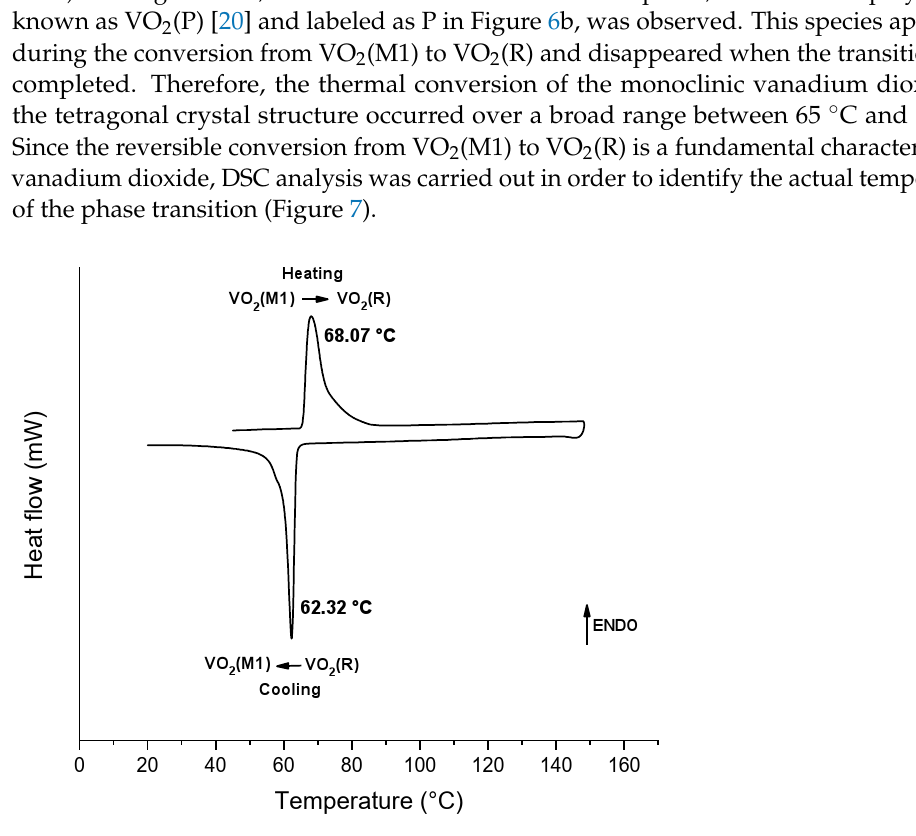
Figure 6. Overlap of the temperature-dependent XRD analysis from 25 ◦ C to 150 ◦ C ( a ), and a focus from 65 ◦ C to 100 ◦ C and from to 29 ◦ (2 θ ) to 46 ◦ (2 θ ) ( b ). The crystalline phases are labeled in ( b ) as M1, R, and P for VO 2 (M1), VO 2 (R), and VO 2 (P), respectively (Co anode).